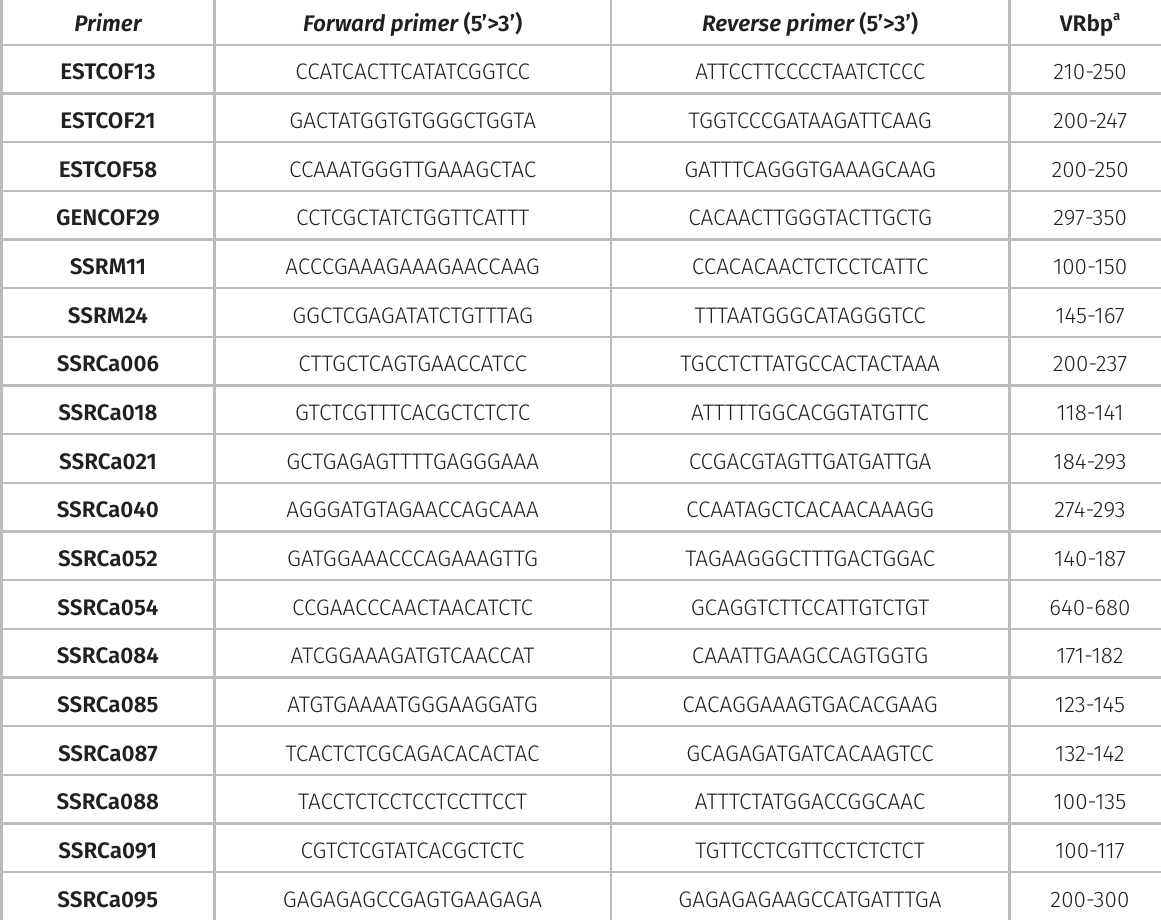
Table III. Microsatellite primers used in the genomic amplification and their respective sequences (5’>3’).